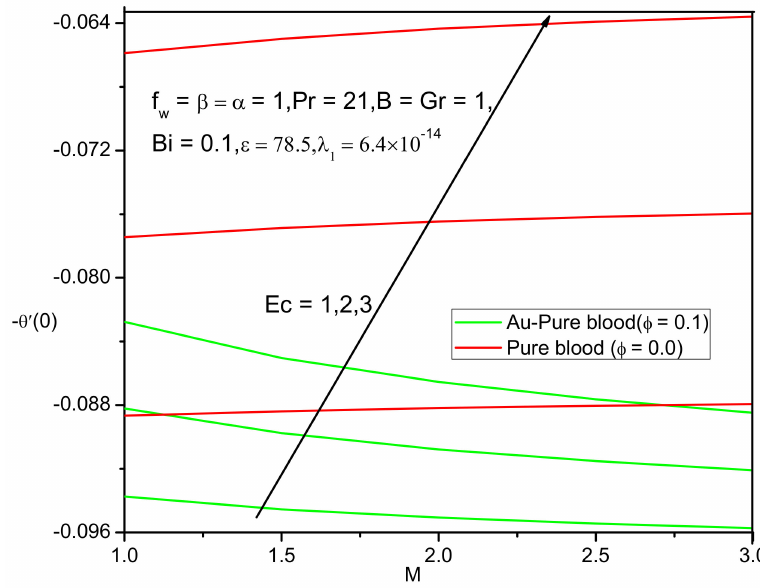
Figure 20. Local Nusselt number − θ (cid:48) ( 0 ) with M for different values of Ec .